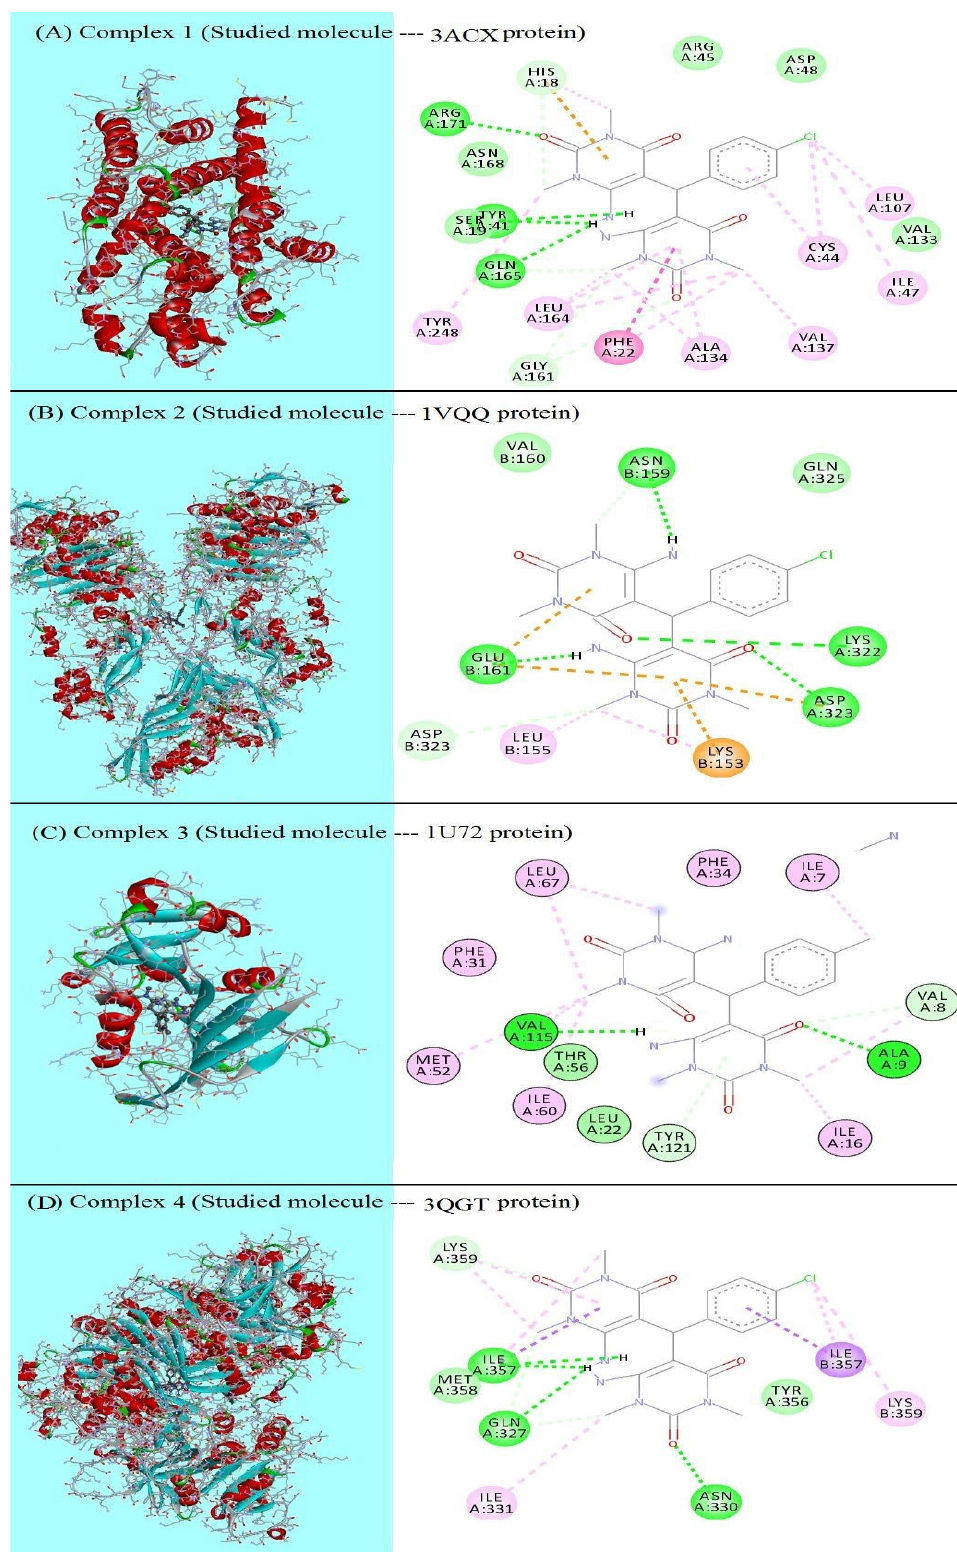
Figure 6. 3D, 2D representations of the interactions of the studied molecule inside the active sites of the target proteins.